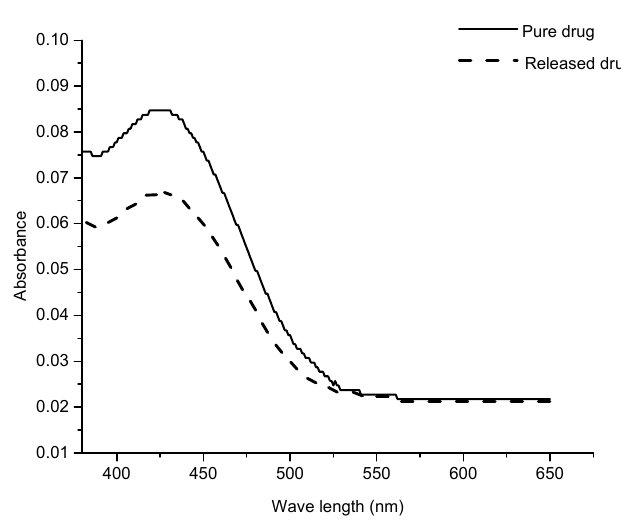
Figure 9. Chemical activity of pure curcumin and curcumin after release.